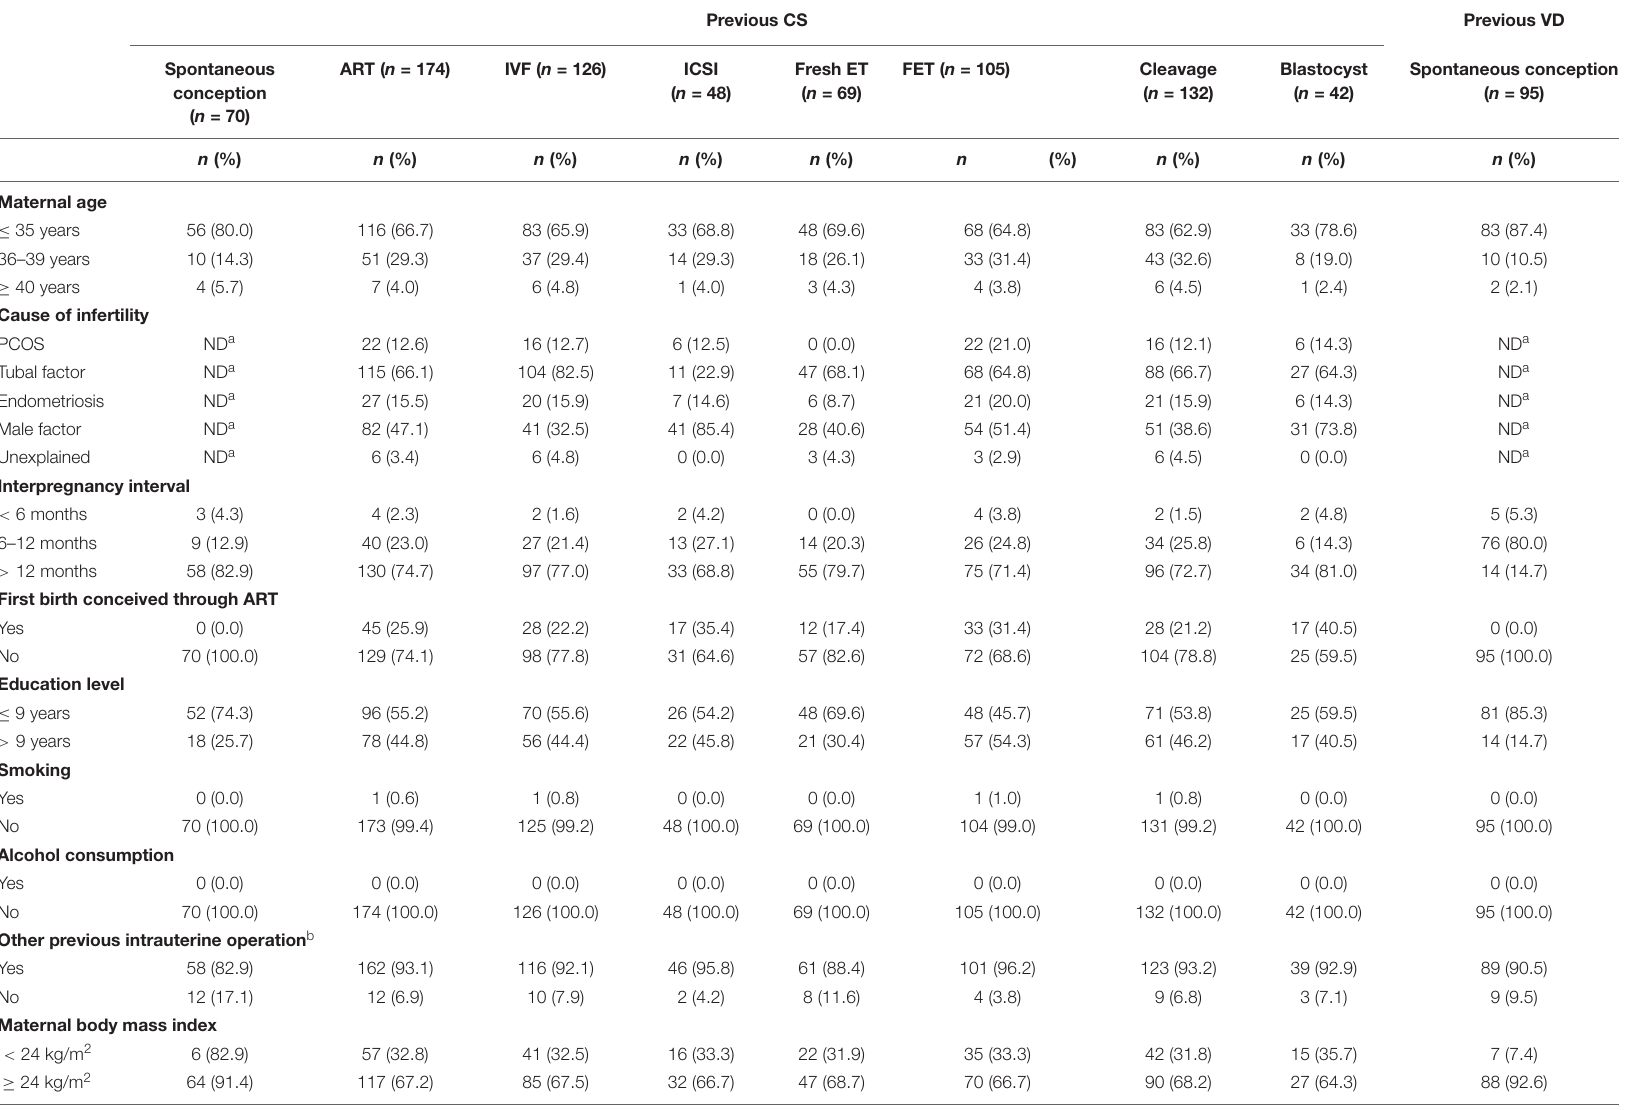
TABLE 2 | Maternal characteristics in subsequent twin pregnancies according to mode of delivery at the first